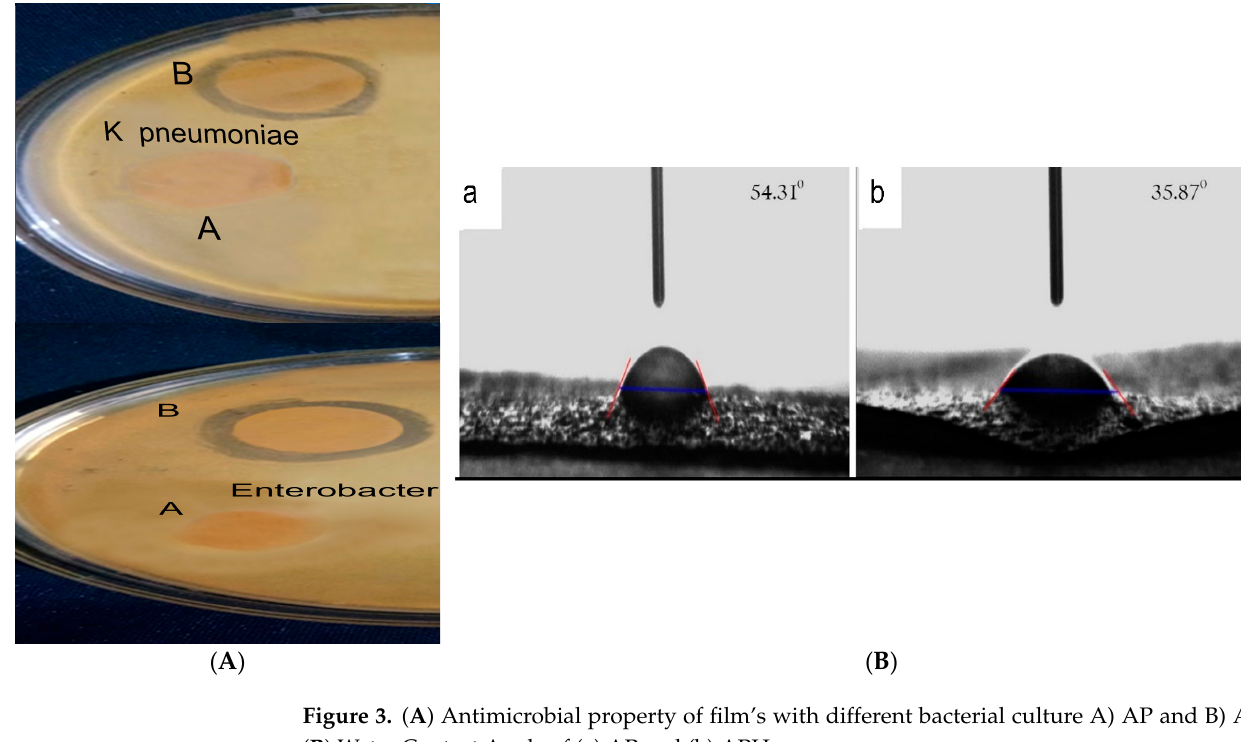
Figure 3. ( A ) Antimicrobial property of film’s with different bacterial culture A) AP and B) APH. ( B ) Water Contact Angle of (a) AP and (b) APH.